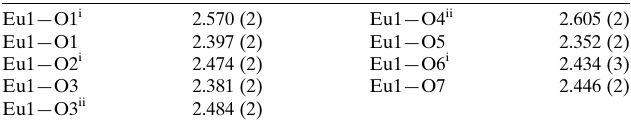
Table 1 Selected bond lengths (A˚ ).